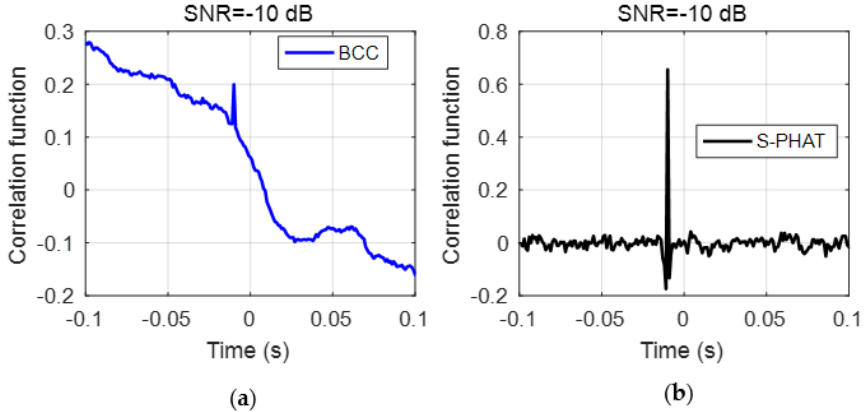
Figure 8. Local results marked by red box in Figure 7: ( a ) the BCC method under SNR = −10 dB; and ( b ) the secondary PHAT cross- correlation method under SNR = −10 dB. ( b ) the secondary PHAT cross-correlation method under SNR = − 10